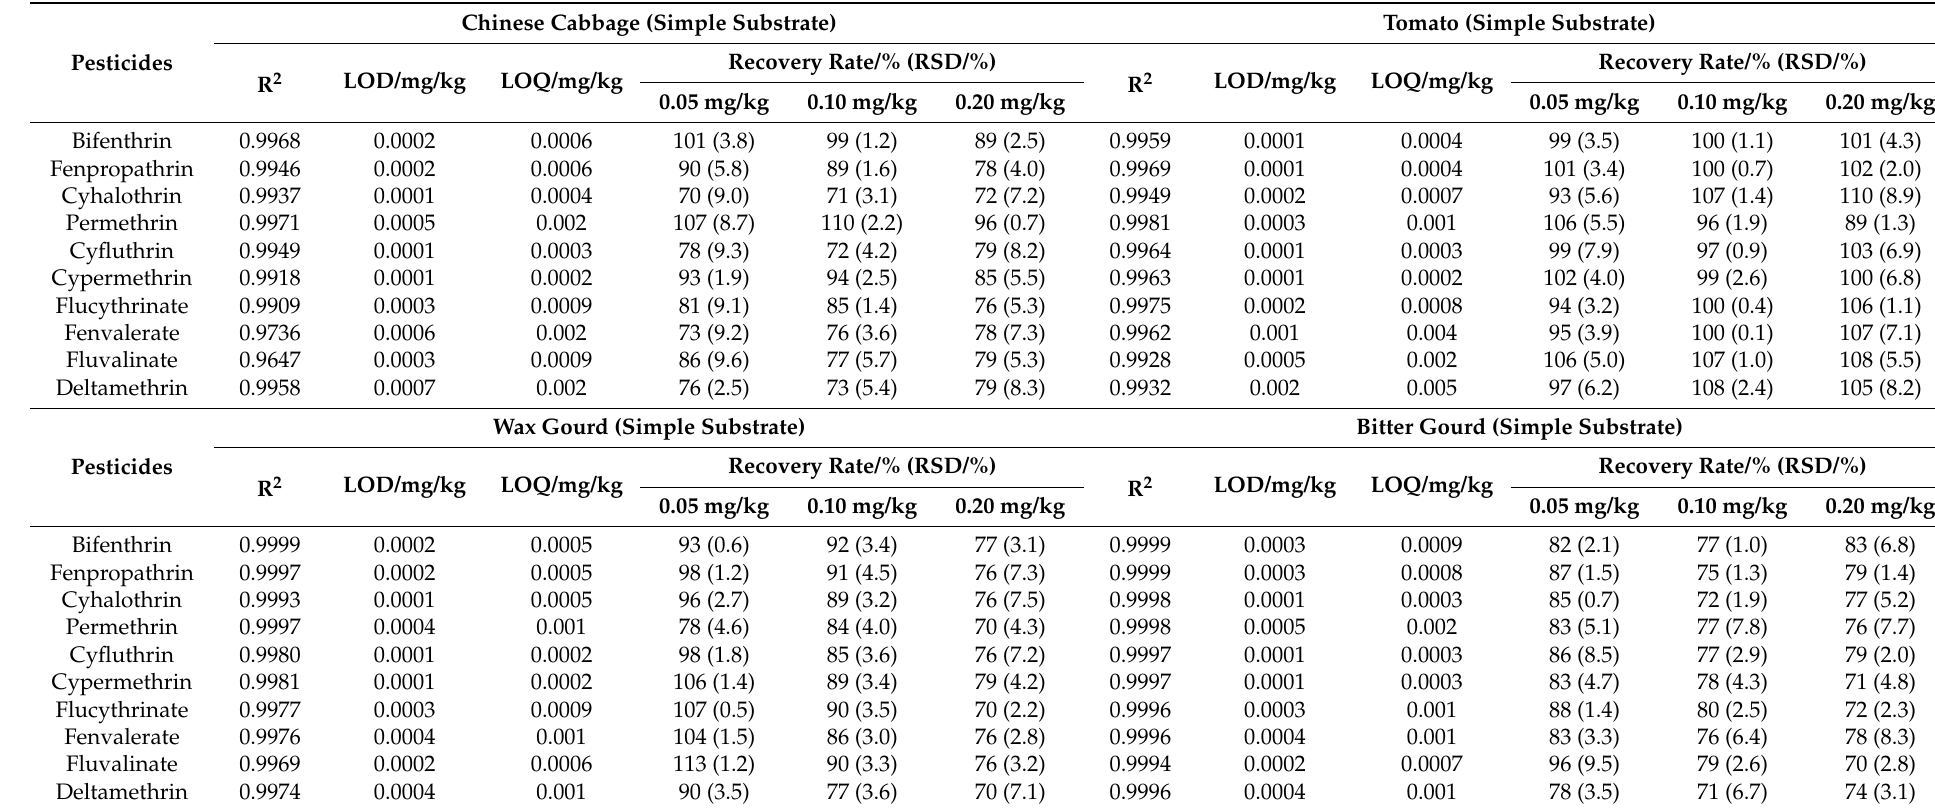
Table 3. Correlation coefficients, detection limits, quantification limits, spike-recovery rates and relative standard deviations of pyrethroid pesticides in 10 vegetables ( n =